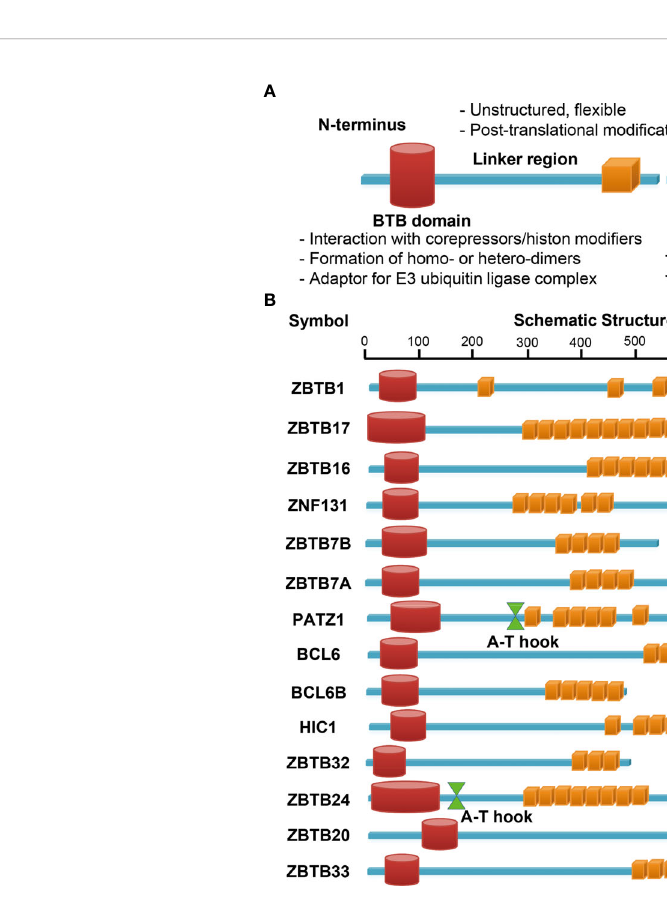
FIGURE 3 | Schematic illustrations of the structure and main function of ZBTB protein domains. The N-terminal BTB domain mainly mediates the protein-protein interactions, while the C-terminal ZFs mainly mediate the bindings to DNA. The ZF domains may interact with other TFs or proteins as well. The linker domain is unstructured, often fl exible and targeted for posttranslational modi fi cations (A) . (B) functional domains of the fourteen ZBTB proteins discussed in this review. PATZ1 and ZBTB24 contain an additional A-T hook domain with DNA-binding